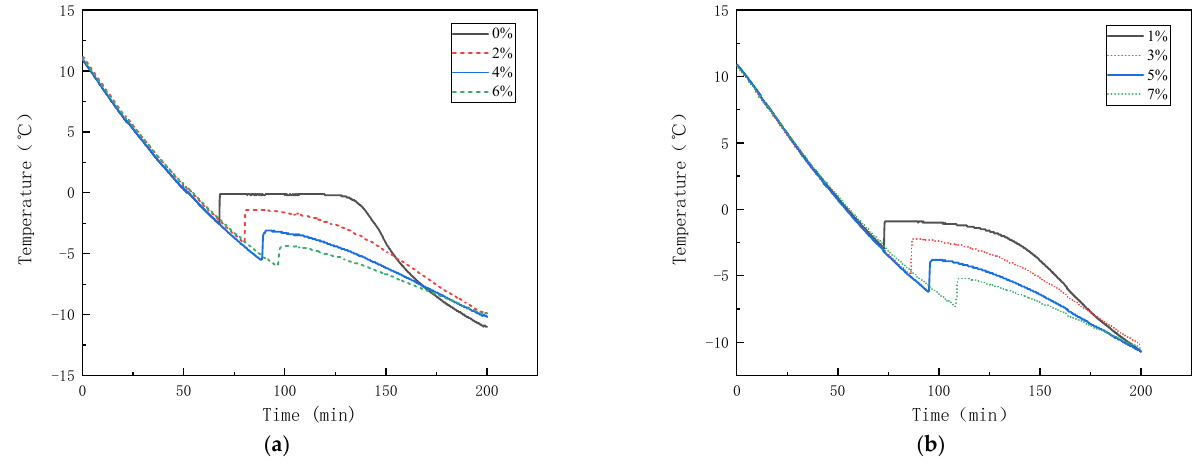
Figure 3. Cooling curve of sand under ( a ) 0%, 2%, 4%, 6%; ( b ) 1%, 3%, 5%, 7%.